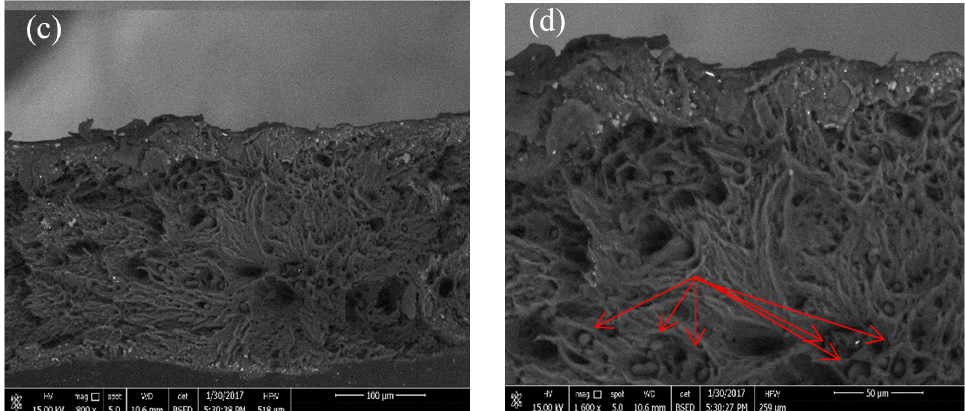
Figure 3. SEM images of the fracture surface of the blend 1 and 3 films after tensile testing; ( a , b ) blend 1; ( c , d ) blend 3.